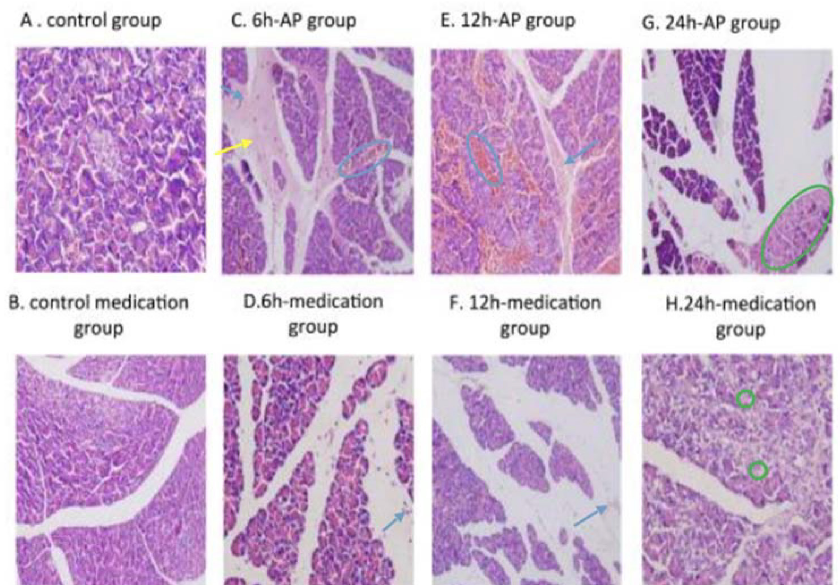
FIGURE 3 - Hematoxylin and eosin (HE) staining (200×). A, B: Normal pancreatic tissue with no pathological damage. C: Edema (indicated by the yellow arrow), inflammation infiltrate (indicated by the blue arrow), and mild hemorrhage (indicated by the blue oval) are evident. D: Inflammation infiltrate (indicated by the blue arrow) is less pronounced than in C. E: Infiltrate (indicated by the blue arrow) and severe hemorrhage (indicated by the blue oval) are clear. F: There is mild infiltrate (indicated by the blue oval). G: Severe acinar necrosis (indicated by the green oval). H: Less pronounced acinar necrosis compared with G (indicated by the green oval).